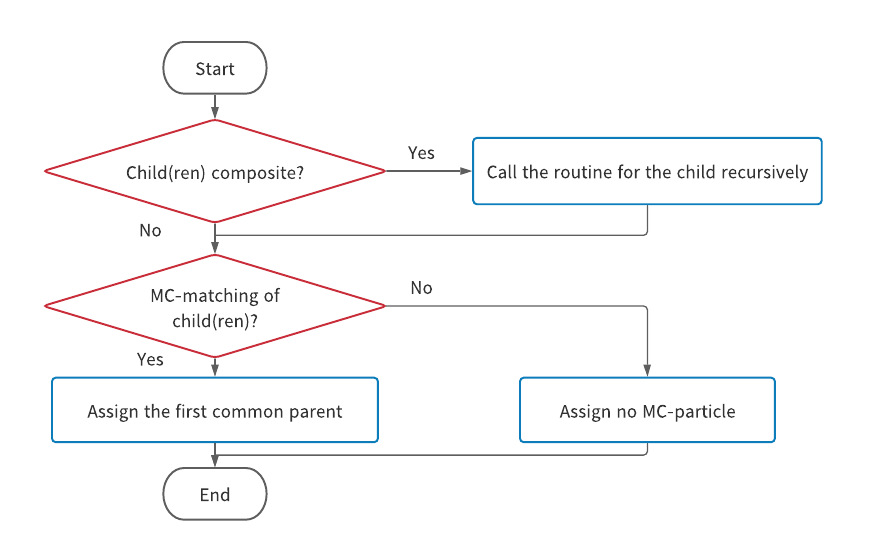
Figure 1. The algorithm flowchart of the MC-matching for a composite